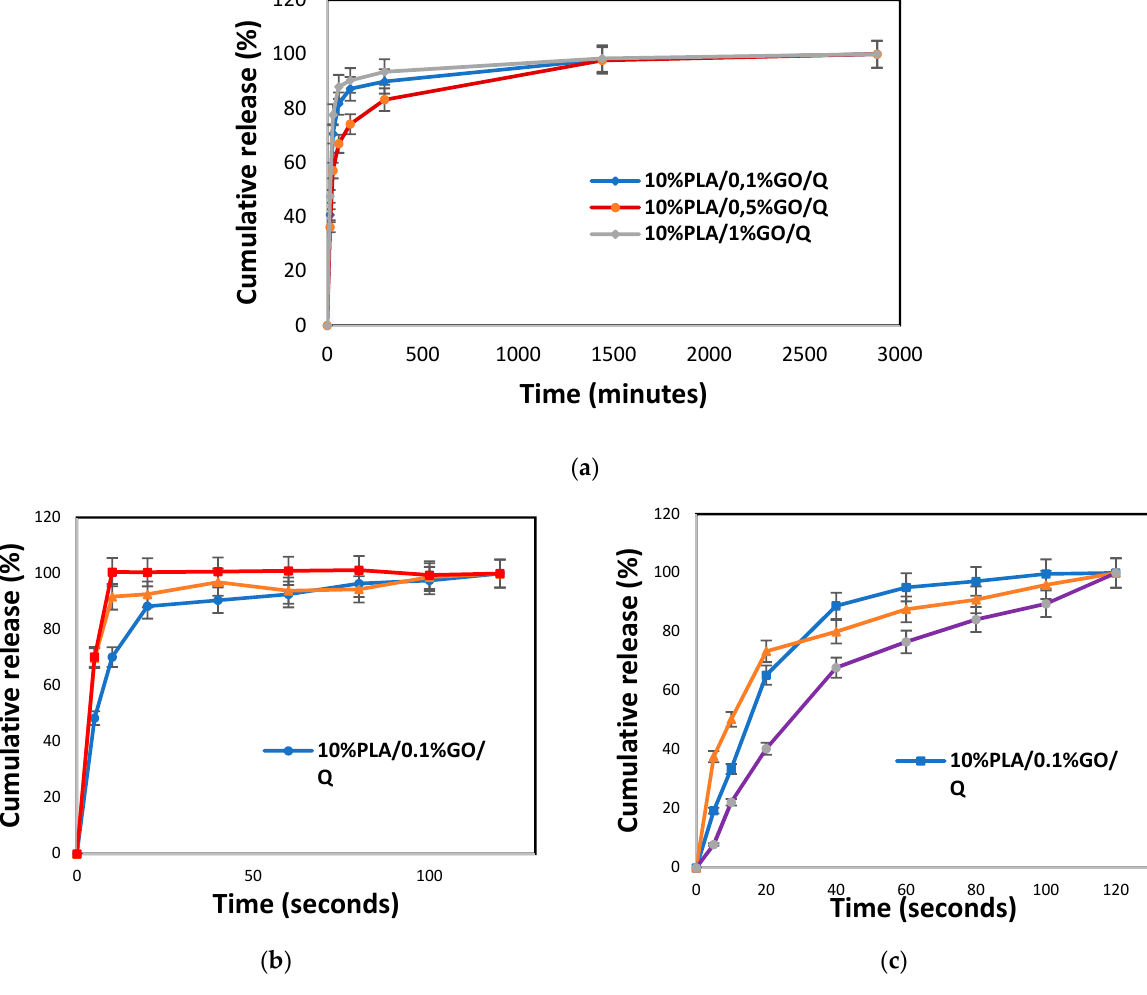
Figure 7. The cumulative release graphs of the drug-loaded microfiber scaffolds without electric stimulus ( a ), and under electric stimulus with two different frequency values: 10 Hz ( b ), 50 Hz ( c ).3.9.2. Electrically Controlled Q Release from the